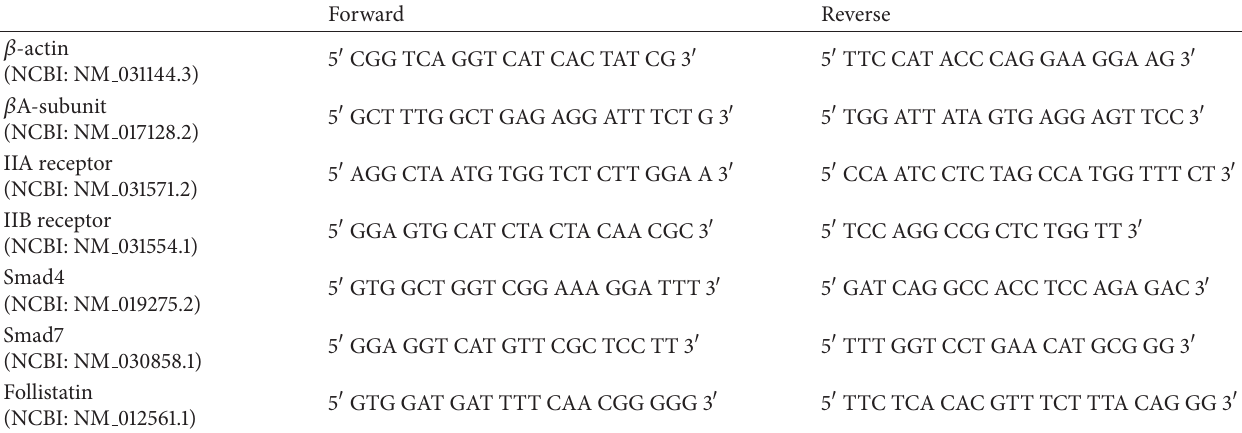
Table 1: The sequences of PCR primers used for the detection of 𝛽 -actin, activin 𝛽 A-subunit, activin type IIA and IIB receptors, Smad4, Smad7, and follistatin including the corresponding genes accession